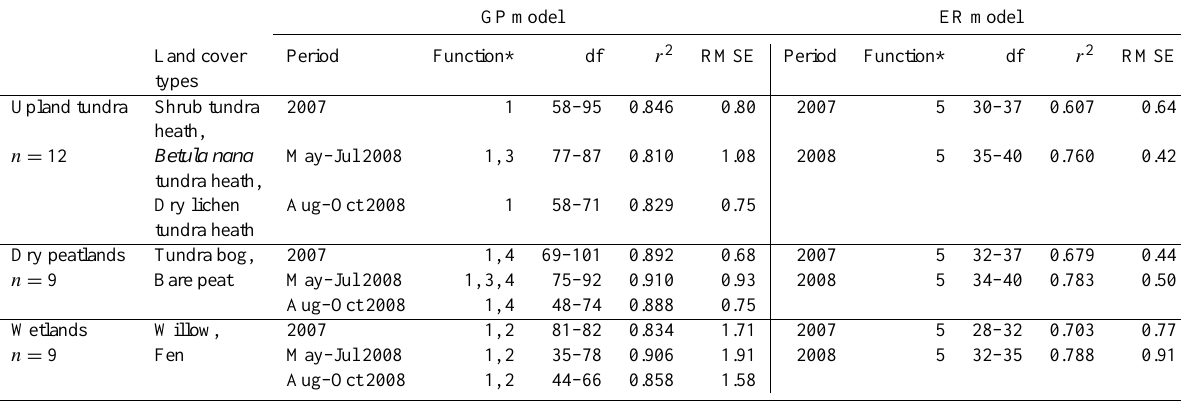
Table 3. Summary of response functions used for obtaining hourly gross photosynthesis (GP) and ecosystem respiration (ER) values for the three main land cover types; df = degrees of freedom, r 2 = coefficient of determination, RMSE = root-mean-square error. Response functions were formulated individually for each microsite (GP) or chamber plot (ER). See Supplement for more details. GP model ER model Land